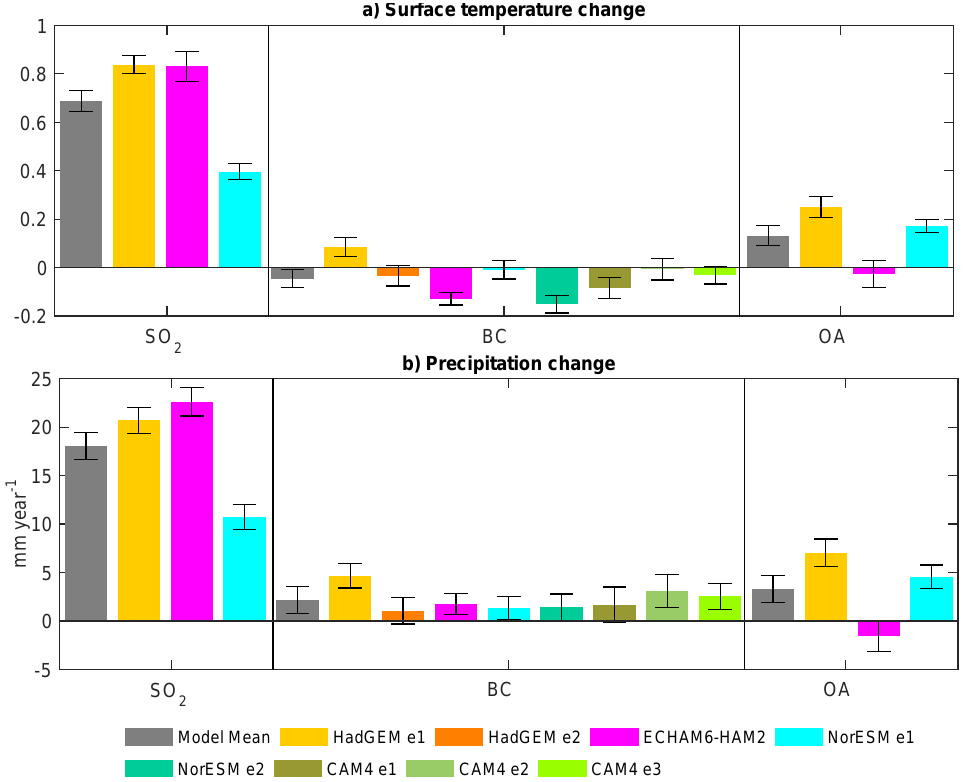
Figure 12. Global-mean annual average changes in (a) surface temperature and (b) precipitation averaged over all land areas excluding ice sheets, from the four ESMs (one was run only for BC), for a complete removal of all land-based emissions of a particular species, compared to the ECLIPSE version 4 baseline emissions for the year 2008 (CESM–CAM4 used the year 2000). The plot shows results averaged over 50-year model simulations; for HadGEM and NorESM (CESM–CAM4), two (three) ensemble members each were run for BC (named e1, e2, e3 in the labels). Error bars are 95% confidence intervals in the mean, based on 50 annual means from each model and thus only reflect the uncertainty of the mean caused by natural variability within each